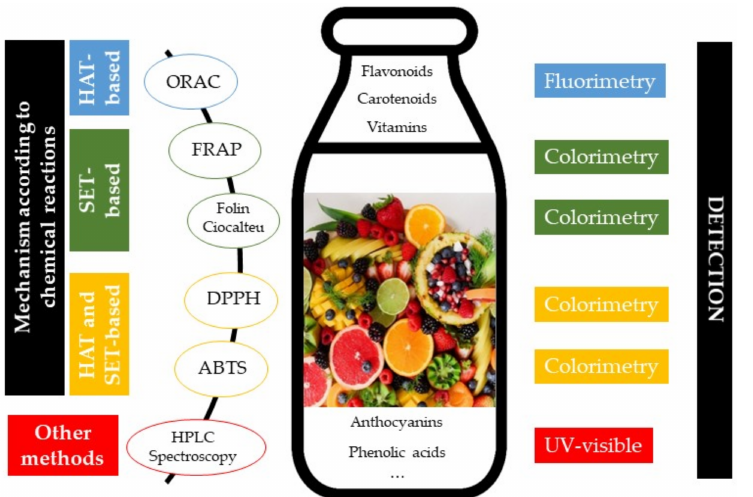
Figure 3. Chemical in vitro methods used for the determination of the antioxidant properties in fruits and fruit-based